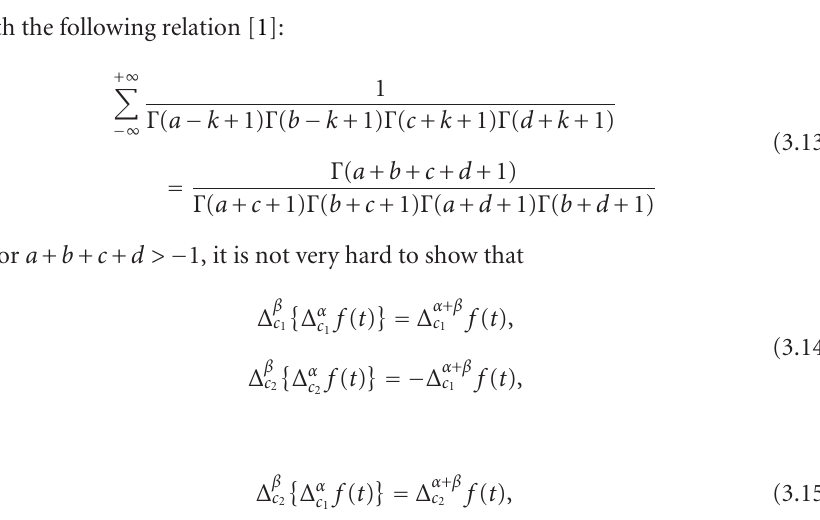
Figure 3.1. Integration path and poles for the integral representation of type 1 di ff